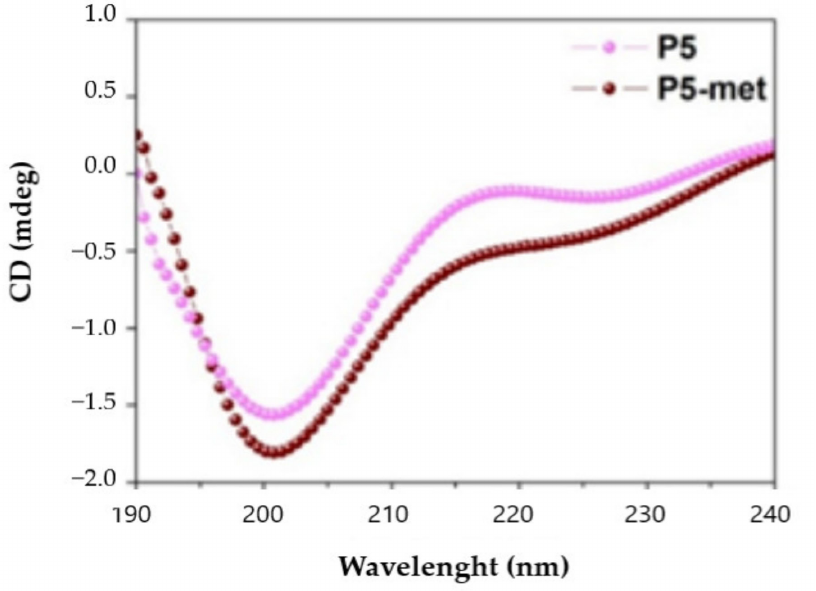
Figure 2. Circular dichroism (CD) spectra of P5 and P5-met registered in the range of 190–240 nm. Afterward, trans-epithelial transport experiments were performed using differentiated Caco-2 cells (Figure 3): the rate of transport of P5-met (incubated alone in the AP compart- ment at the concentration of 500 µ M) up to 30 min was 81.7 nmoles ± 0.3 ng/(mL × min) ( R 2 0.99). A decline in transport rate was observed after 60 min (data not shown) prob- ably due to a decline of P5-met concentration in the donor AP compartment, caused